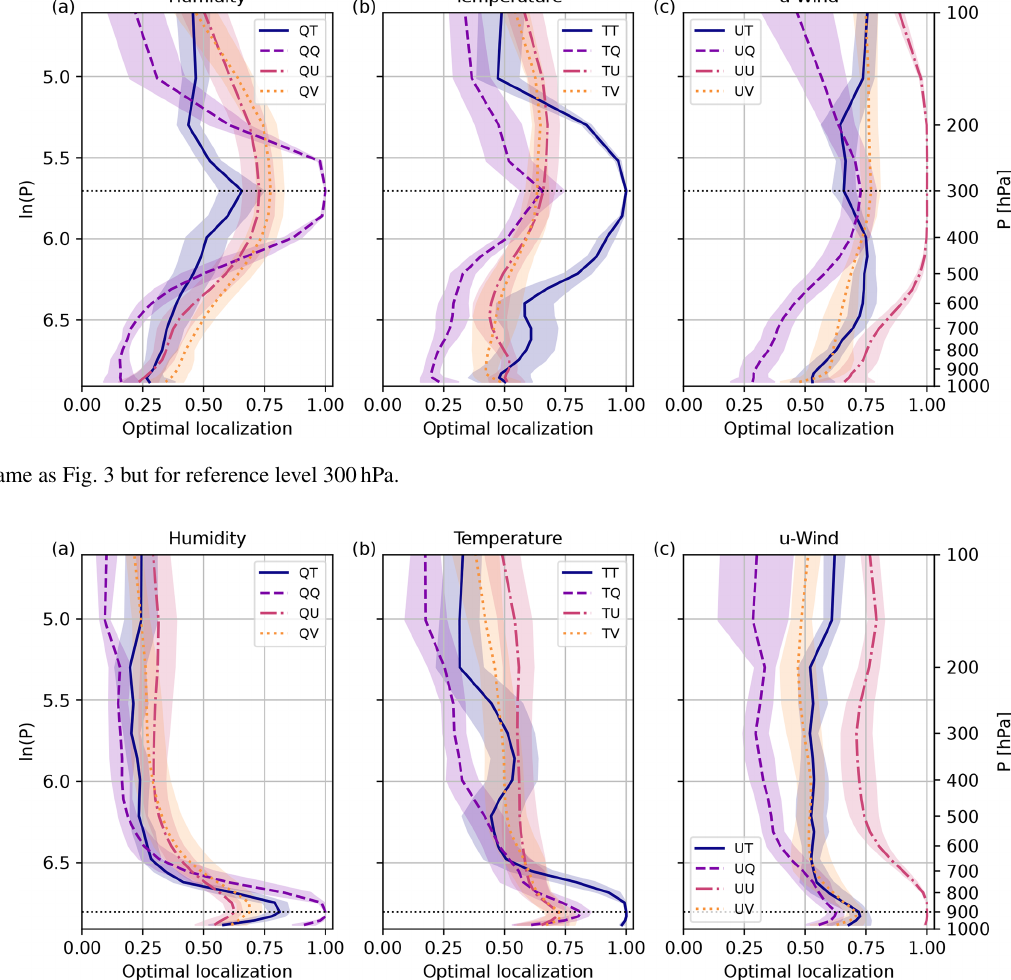
Figure 5. Same as Fig. 3 but for reference level